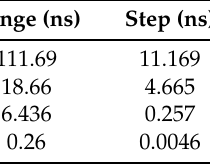
Figure 9. The testing platform of the DCO chip. Table 2. Measurement results of step/range of tuning